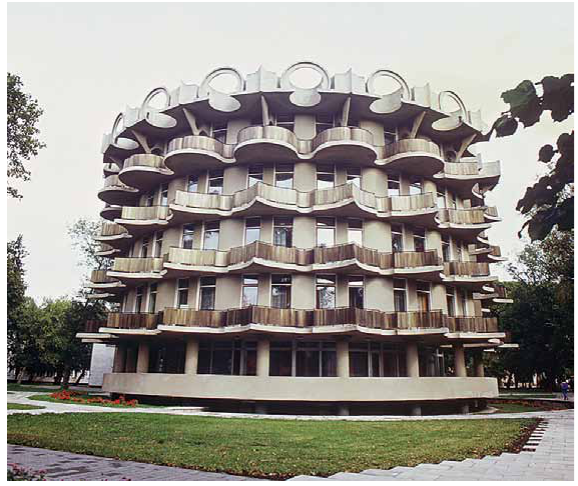
Fig. 2. Sūrutis sanatorium in Druskininkai block (archit. aušra and juozas Šilinskai, 1982, cur. Pušynas